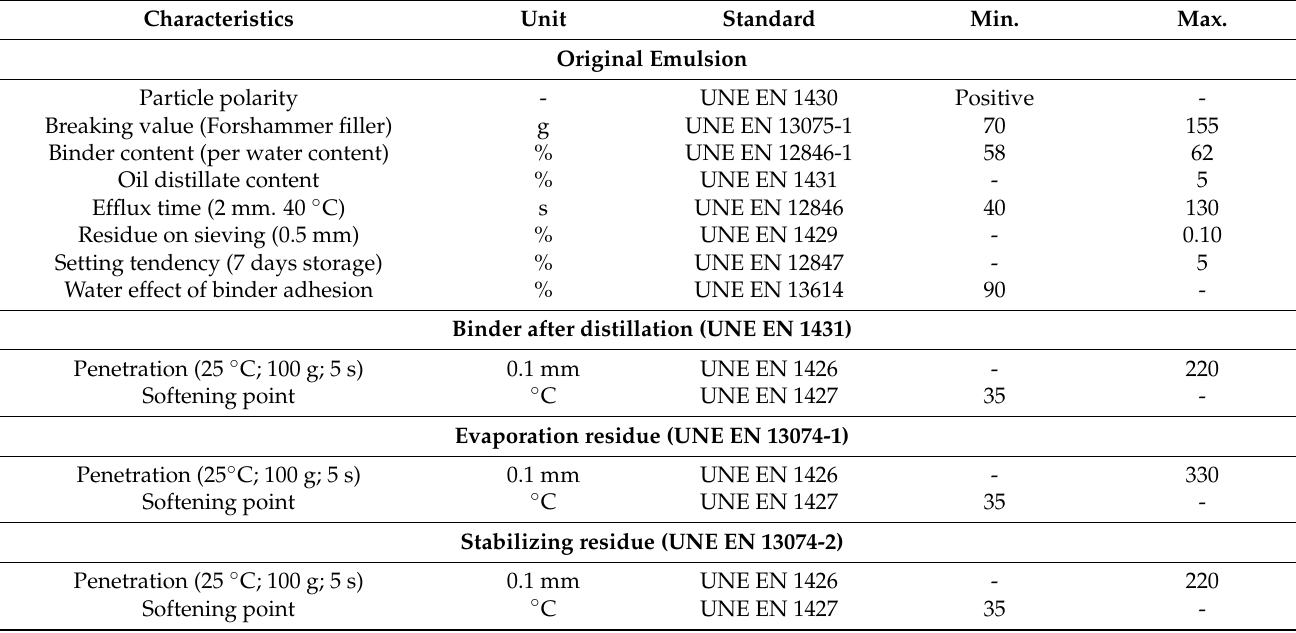
Table 1. Technical details of the bitumen emulsion C60BF3 MBA